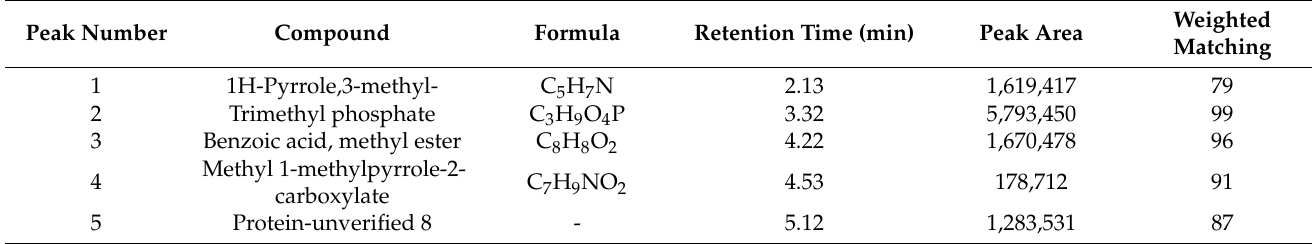
4. Conclusions A Jiatang scroll painting drawn in the seventh year of Guangxu (AD 1881) was studied. Microscopic studies were performed using fiber analyzer, Fourier transform in- frared spectroscopy (FTIR), and Herzberg stain. It was determined that cotton fibers were used in the weaving of the canvas of the Jiatang scroll painting. The results provide a reference for the subsequent repair of the damaged parts of the Jiatang scroll painting. Cotton fibers can then be used to repair the damaged parts of the fabric. According to the SEM-EDS and Raman spectroscopy analysis, the pigments used in the painting were mainly cinnabar, carbon black, and emerald green, which are all mineral pigments. Ac- cording to the features of mineral pigments, they are not sensitive to water, which can provide the reference for the chosen cleaning and conservation methods. The adhesives were proved to be animal glue, benzoin gum, and starch, as identified by Py-GC/MS. The animal glue and starch are assigned to the pigment binder and sizing material separately. The benzoin gum is contamination from the incense burning during the process of an- cestor worship, so it should be removed. These results lay an important foundation for